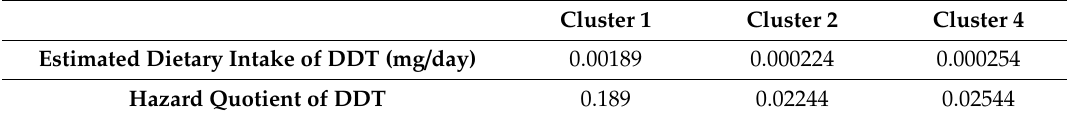
Table 6. EDI and HQ values for the concerned clusters regarding